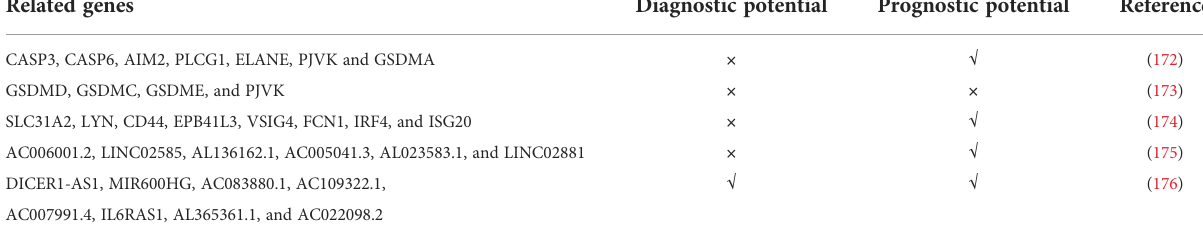
TABLE 5 Pyroptosis-related genes in patients with ovarian cancer. Related genes